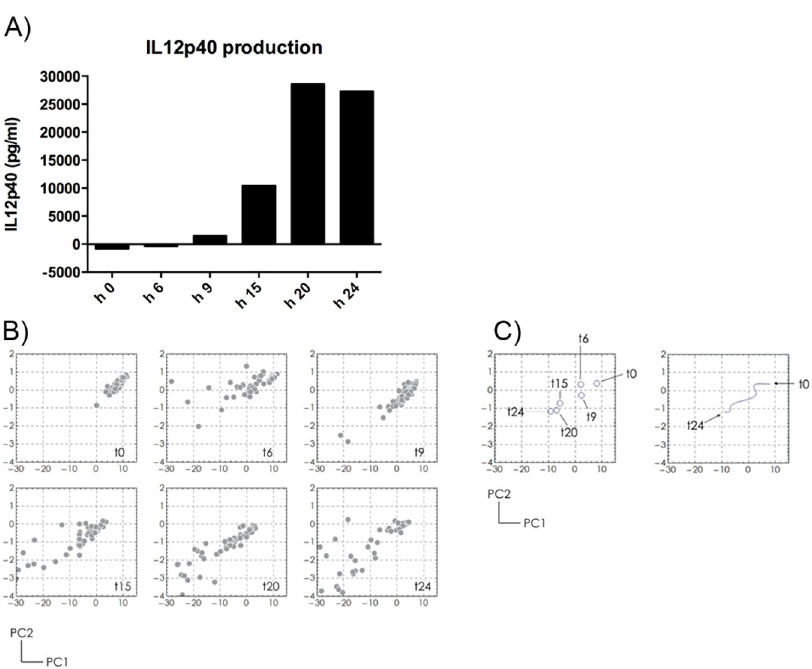
Fig 6. Analysis of the Raw 264.7 conditioned medium after LPS stimulation. Raw 264.7 cells are stimulatedwith LPS for 24 hours. At 0, 6, 9, 15, 20, 24 hours, A) IL12p40productionwas quantified by ELISA and B) Raman spectra of conditioned medium were collected.By PCA analysis, the spectra collectedat each time point clusterize. C) The cluster centers for each time point are reported(left panel)as well as the trajectory described(right